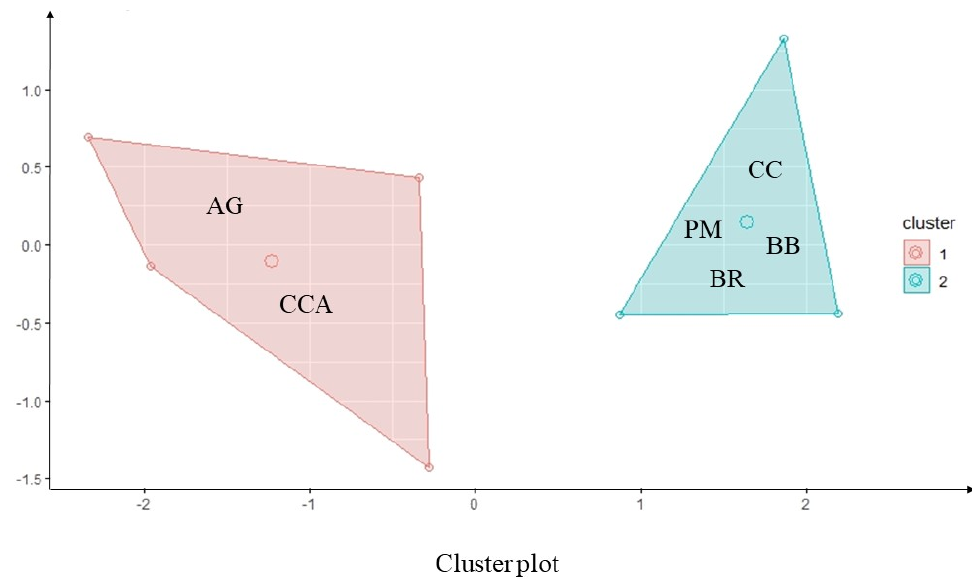
Figure 5. Distribution of systems with sorghum + grasses ( Andropogon gayanus —AG; Cenchrus ciliaris cv. Aridus—CCA; Cenchrus ciliaris cv. 131—CC; Brachiaria decumbens —BD; Brachiaria brizantha —BB; Brachiaria ruziziensis —BR; Panicum maximum —PM) in the Clusters 1 and 2. The cluster was classified using the data of grain yield, bulk density, and soil porosity. Bulk density and soil porosity were monitored in the soil layer (0.0–0.2